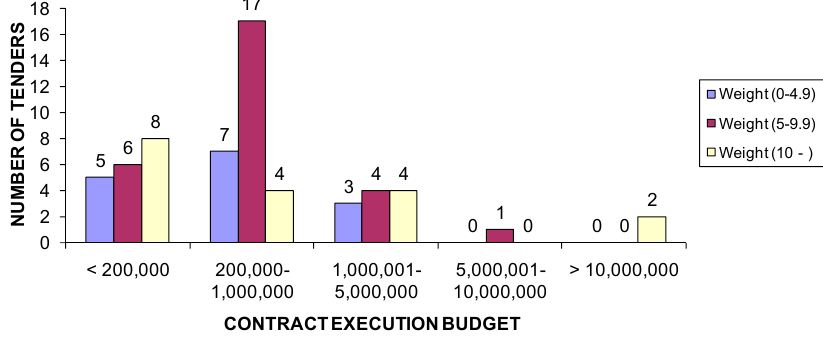
Figure 4. Number of tenders according to environmental criteria weighting by contract size (in euros).